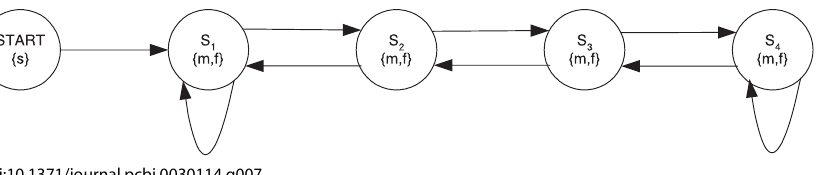
Figure 7. Consecutive Fragment Matches